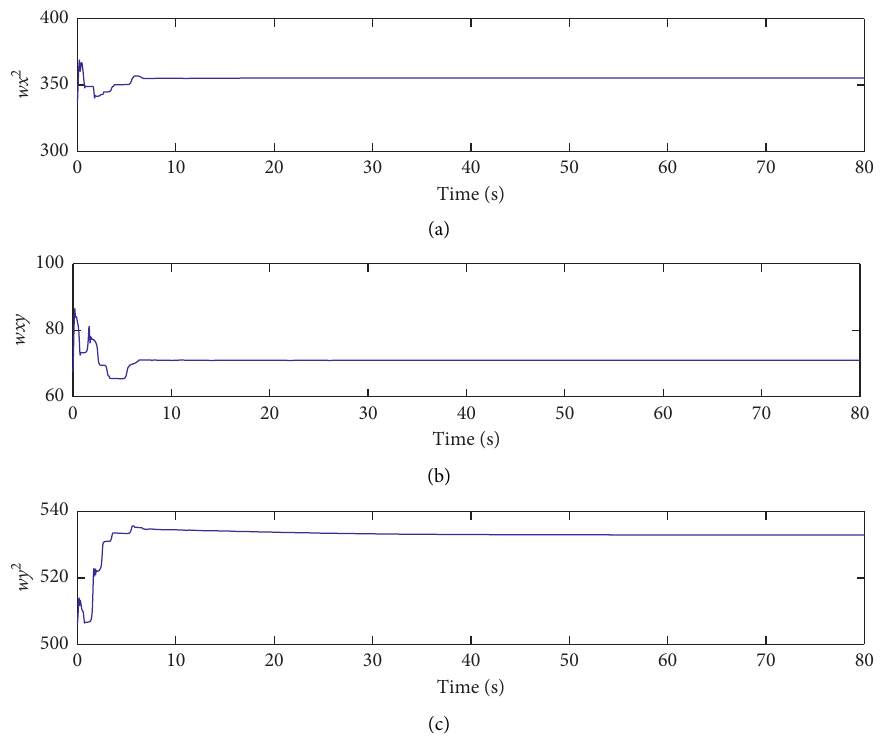
Figure 14: Adaptation of spring constants using fractional